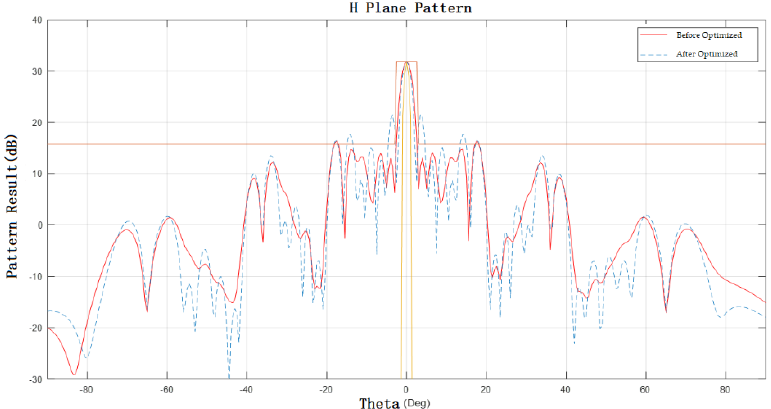
Figure 6. Directional maps of E ‐ plane and H ‐ plane of the array after subarray position optimization at 0 ‐ degree scanning angle.